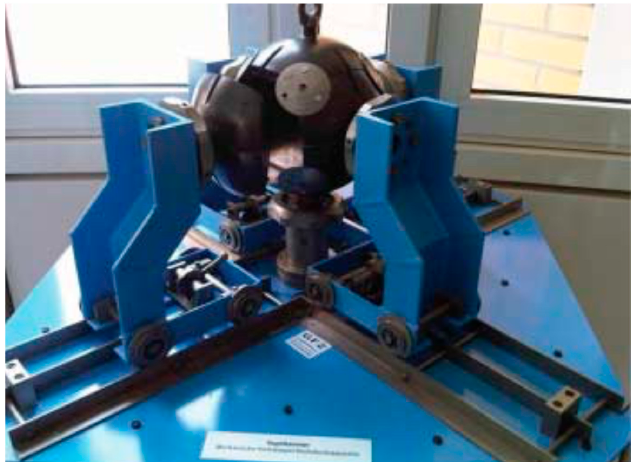
Figure 12. Split-sphere high pressure chamber.